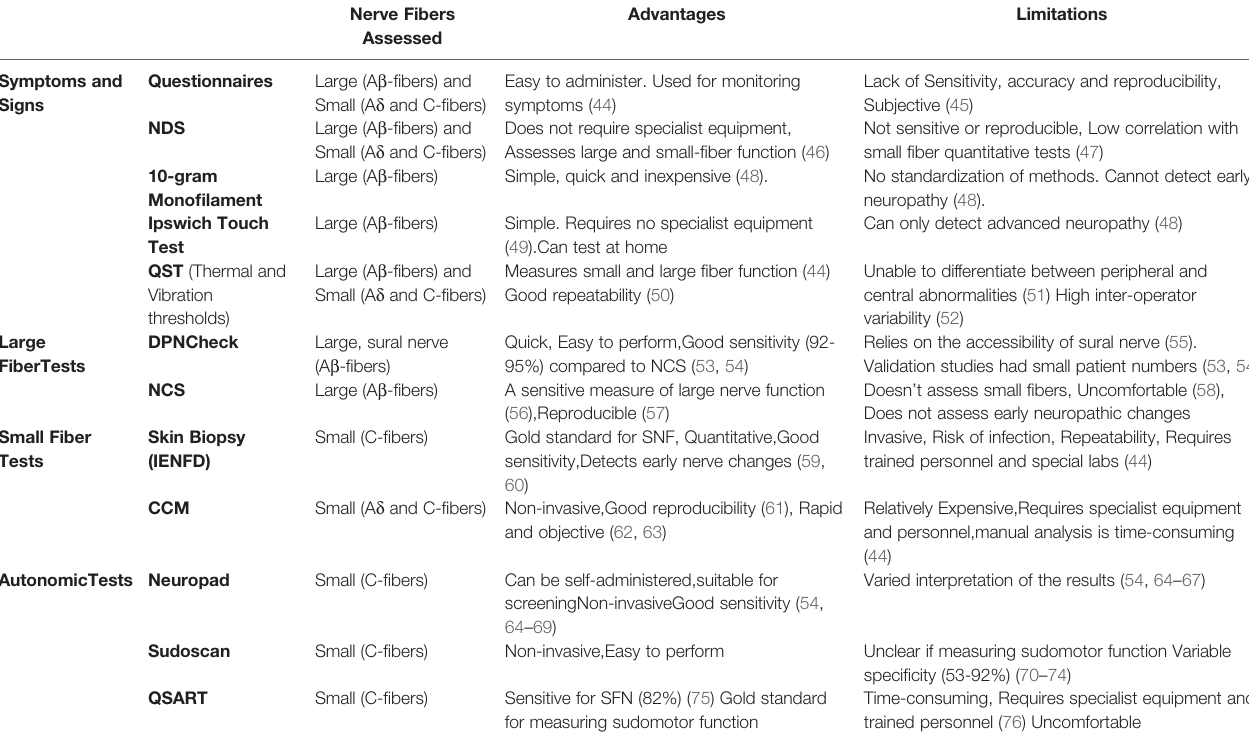
TABLE 2 | Diagnostic tests available for assessing